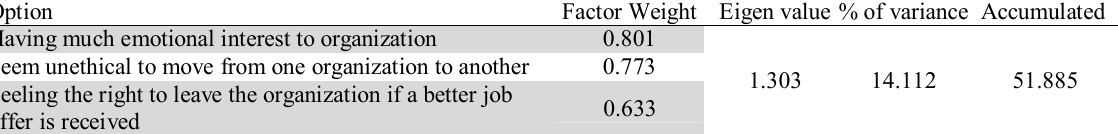
Details of factor analysis for Moral commitment factors in Organizational commitment Option Factor Weight Eigen value % of variance Accumulated